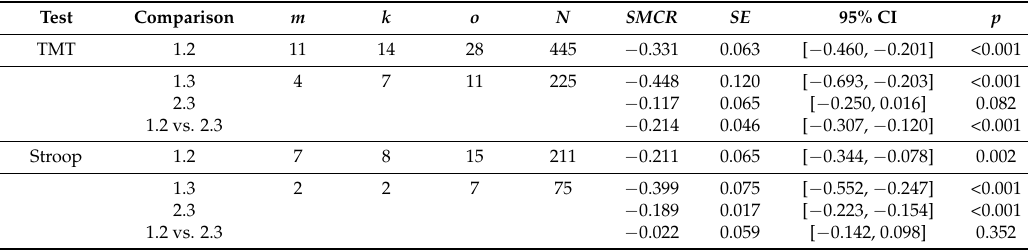
Table 3. Meta-Analytically Derived Effect Sizes for RT Reduction Due to Retesting: Stroop tasks and variants of the